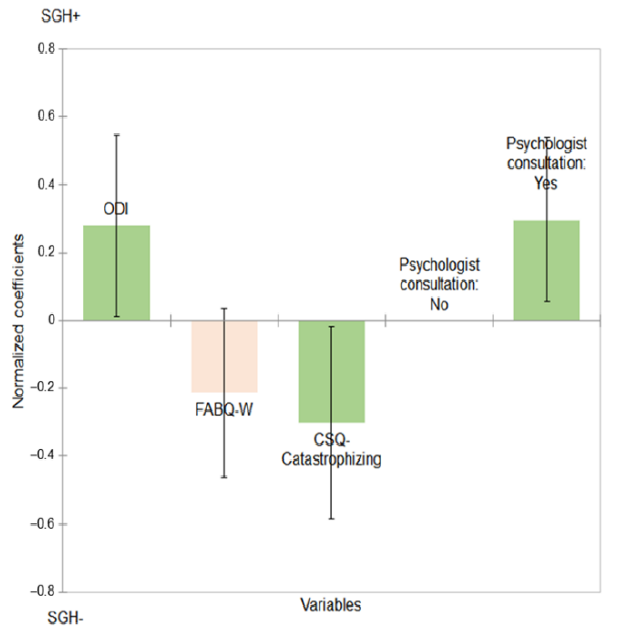
Figure 1. Representation of the logistic regression showing the standardized coefficients (95% CI) between Social Gradient of Health (SGH) and several dependent variables.